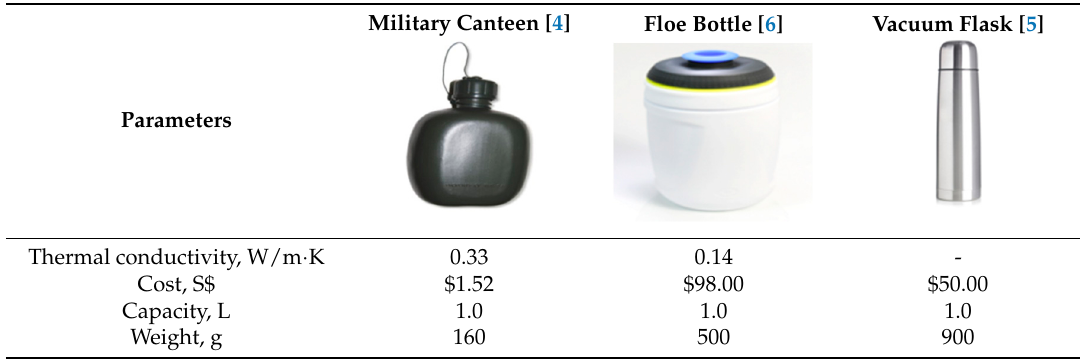
Table A1. Property comparison of various bottles.